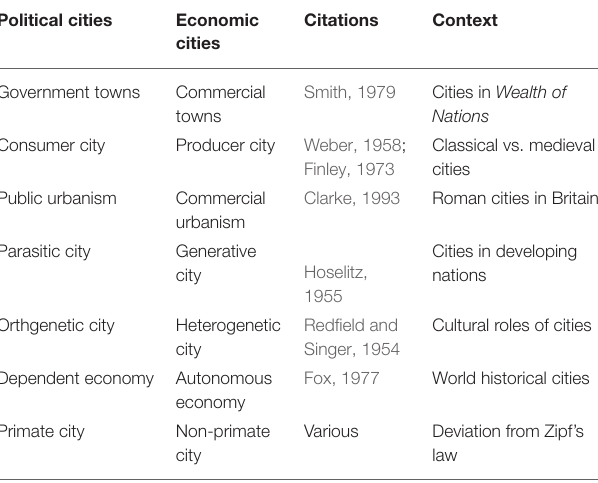
TABLE 1 | The city as two things: dichotomous city